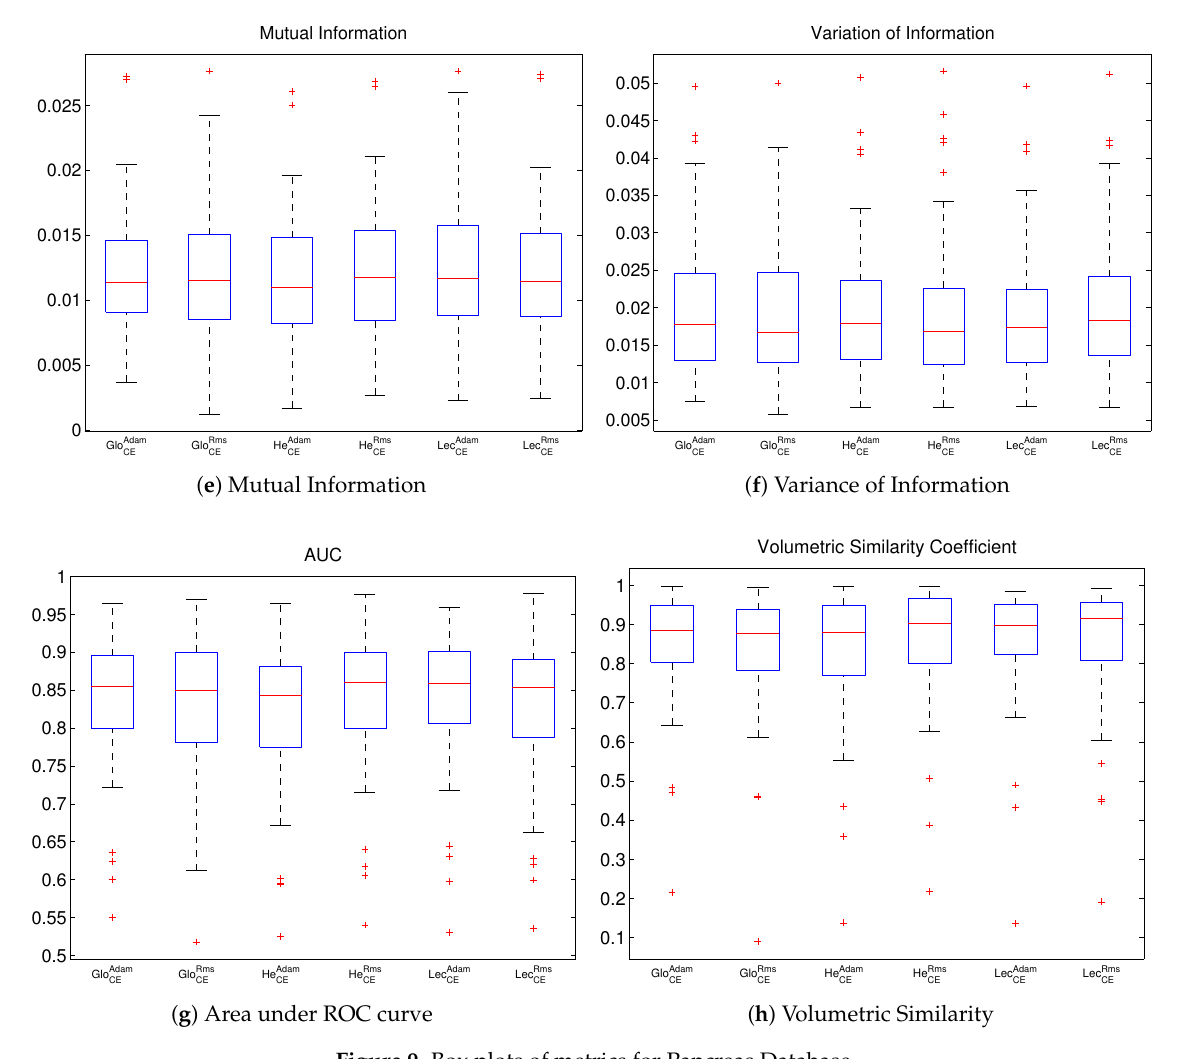
Figure 9. Box plots of metrics for Pancreas Database.